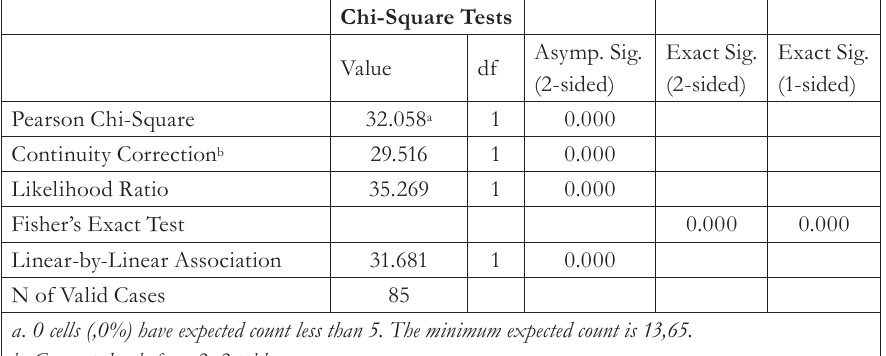
Tab. 6 - Satisfaction with price of provided banking products versus nationality. Source: Author´s own,